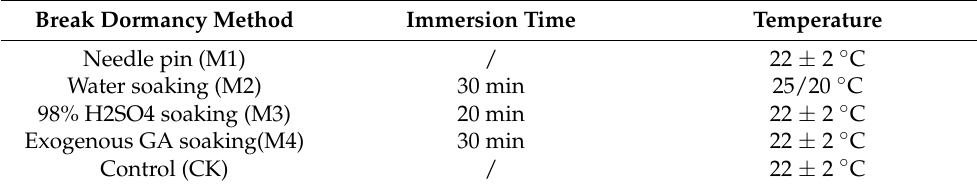
Table 2. Experimental design of germination tests conducted in